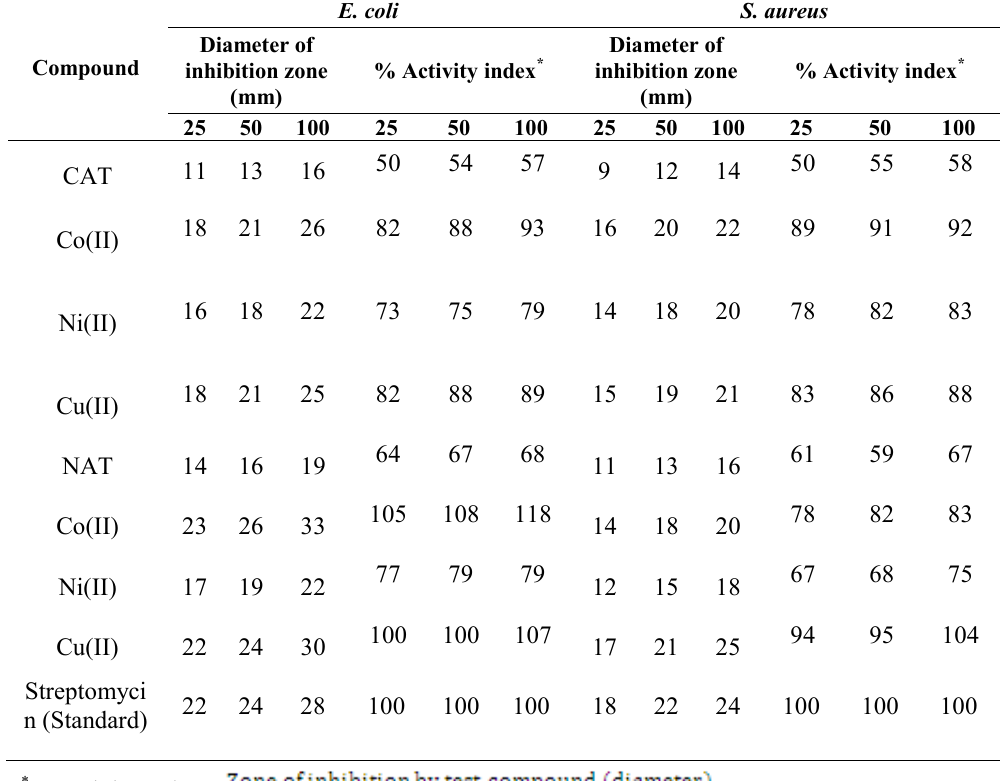
Table 3. Antibacterial screening data for the ligands and their complexes. E. coli Compound